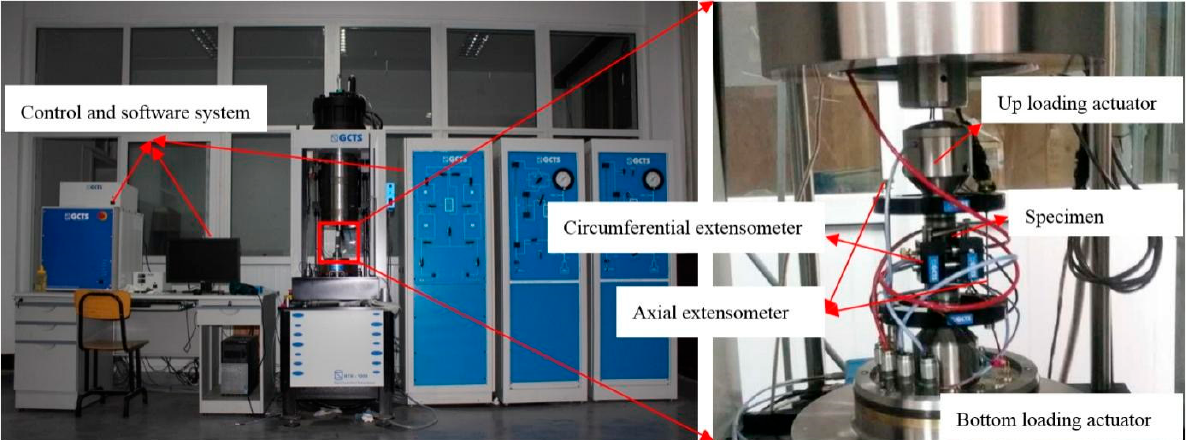
Figure 3. Illustration of the GCTS RTR-1000 testing system. The ( right ) photograph is the enlarged drawing of the red frame in ( left ) photograph [21,22].